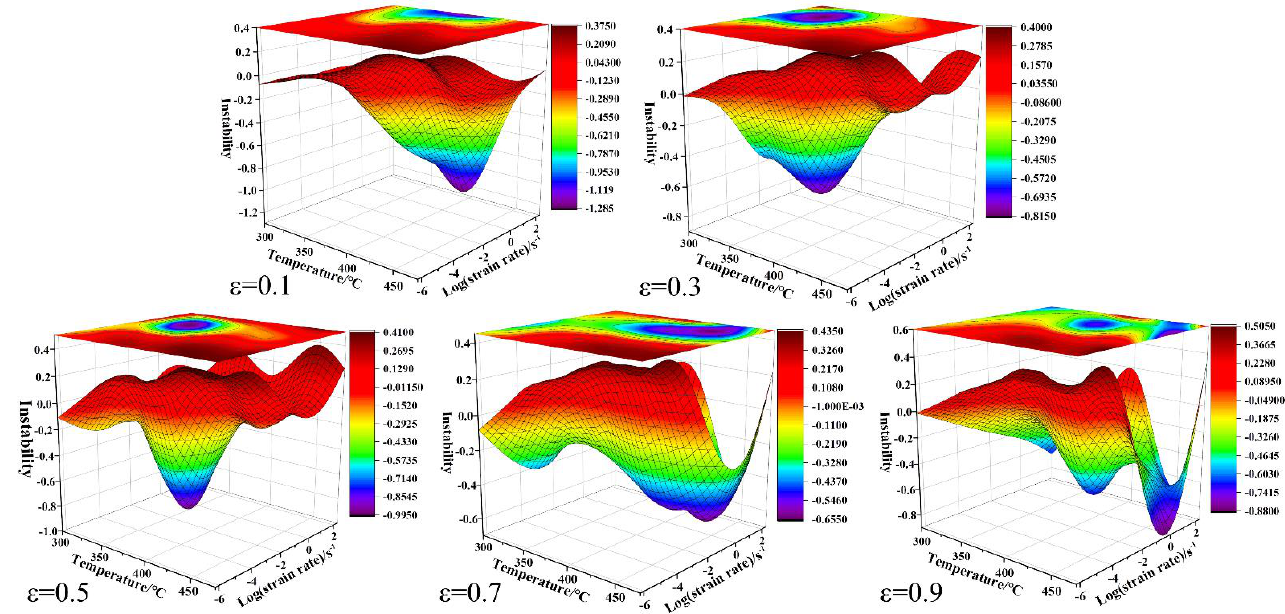
Figure 11. Different instability zones at the different strains. Figure 12 exhibits the hot processing maps of Mg-8.7Gd-4.18Y-0.42Zr alloy at strains 0.1, 0.3, 0.5, 0.7, and 0.9, respectively, which are gained by superimposing the power dis- sipation diagram and the instability diagram. In these maps, the contour line values rep- resent the power dissipation values ( η ), and the shaded domains represent the unstable deformation under different strains. Comparing the hot processing map under different strain levels. It can be found that the region with larger power dissipation efficiency ( η ) is almost concentrated in a relatively fixed range that is a low strain rate and high defor- mation temperature. There is no obvious change in the safety deformation domain,